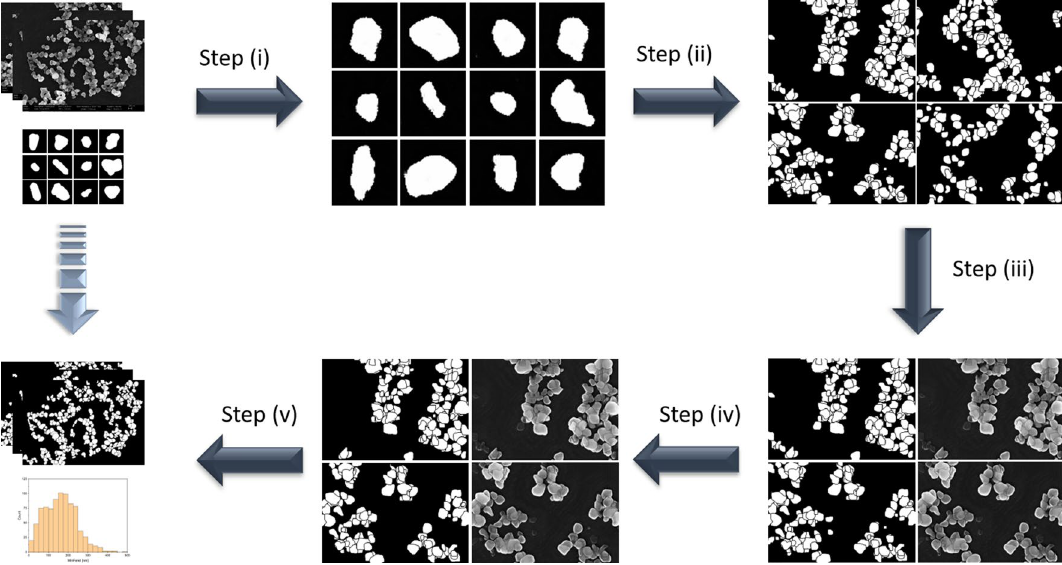
Figure 1. Simplified schematic illustration of the workflow. Data in the top left panel, i.e., scanning electron microscopy micrographs and some representative outlines of particle shapes have to be provided by the user, all other steps are done automatically. In step (i) a Wasserstein GAN is used to produce more particle shapes similar to those provided by the user. In step (ii), they are assembled into fake segmentation masks. In step (iii), a cycleGAN is trained on real SEM images and the fake masks generated in the previous step. In step (iv), artifacts are removed, yielding a set of realistic-looking, fake SEM images and their corresponding segmentation masks. In step (v), a MultiRes UNet segmentation model is trained on these fake data and finally used to produce segmentation masks that can be used to extract further information such as particle size distributions from the real SEM